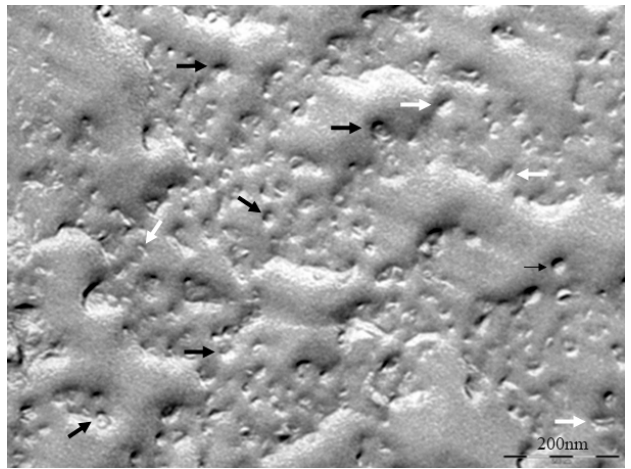
Figure 9. Electron micrograph of DMPC/DHPC q = 2 bicelles. The image depicts a zone full of bicelles. Black arrows denote disks viewed face-on and white arrows denote disks viewed